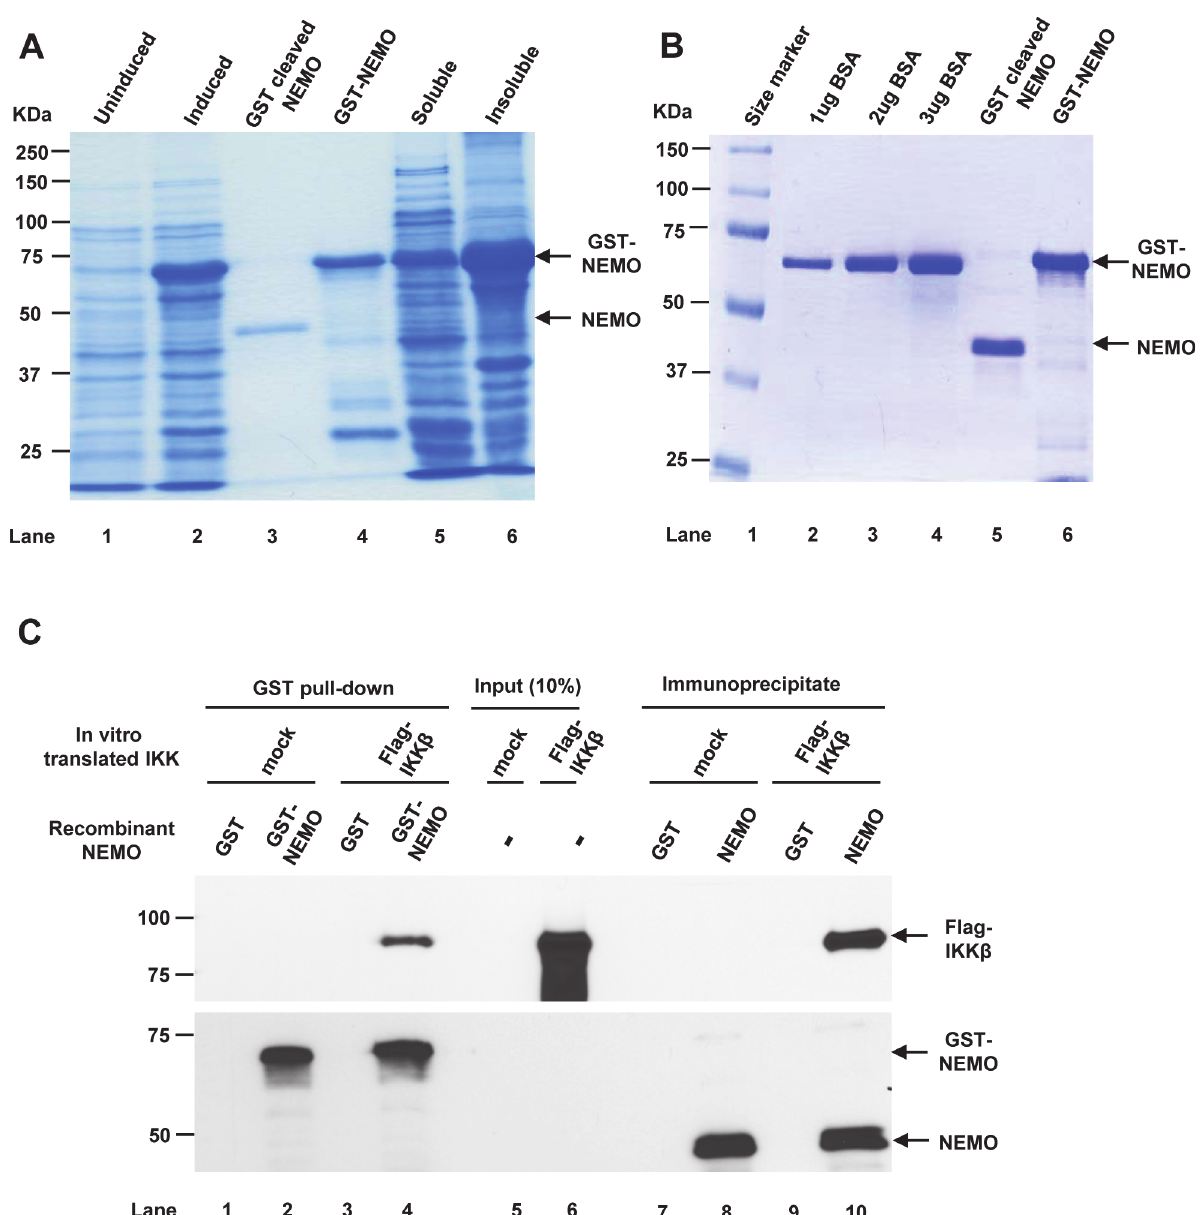
Fig 1. Purification of full length recombinant human NEMO protein. (A) SDS – PAGE gel stained with Coomassie Brilliant Blue R-250 for the protein purification profile. (B) 10 μ l of purified recombinant NEMO proteins were loaded with a serial dilution of BSA at known concentrations (C) GST or GST- NEMO protein was incubated with in vitro translated mock or IKK β for GST pull-down assay (lane 1 – 4), or GST or GST-cleaved NEMO protein was incubated with in vitro translated mock or flag-IKK β for co-immunoprecipitation with anti-NEMO antibody (lane 7 – 10). Flag-IKK β in the complexes or inputs (lanes 5 and 6) were separated on SDS-PAGE gel and immunoblotted with flag